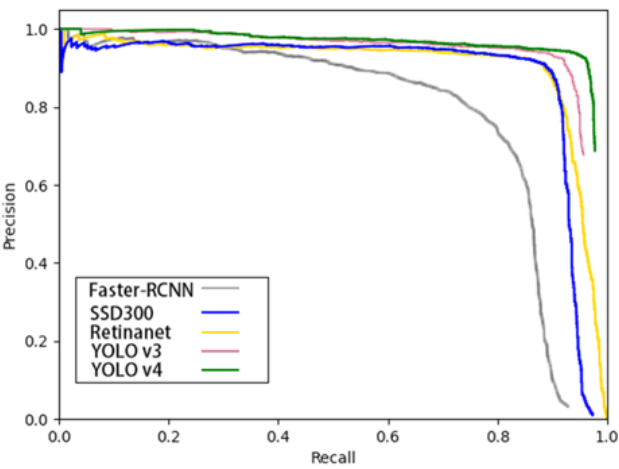
Figure 7. The P-R curves of different algorithms.